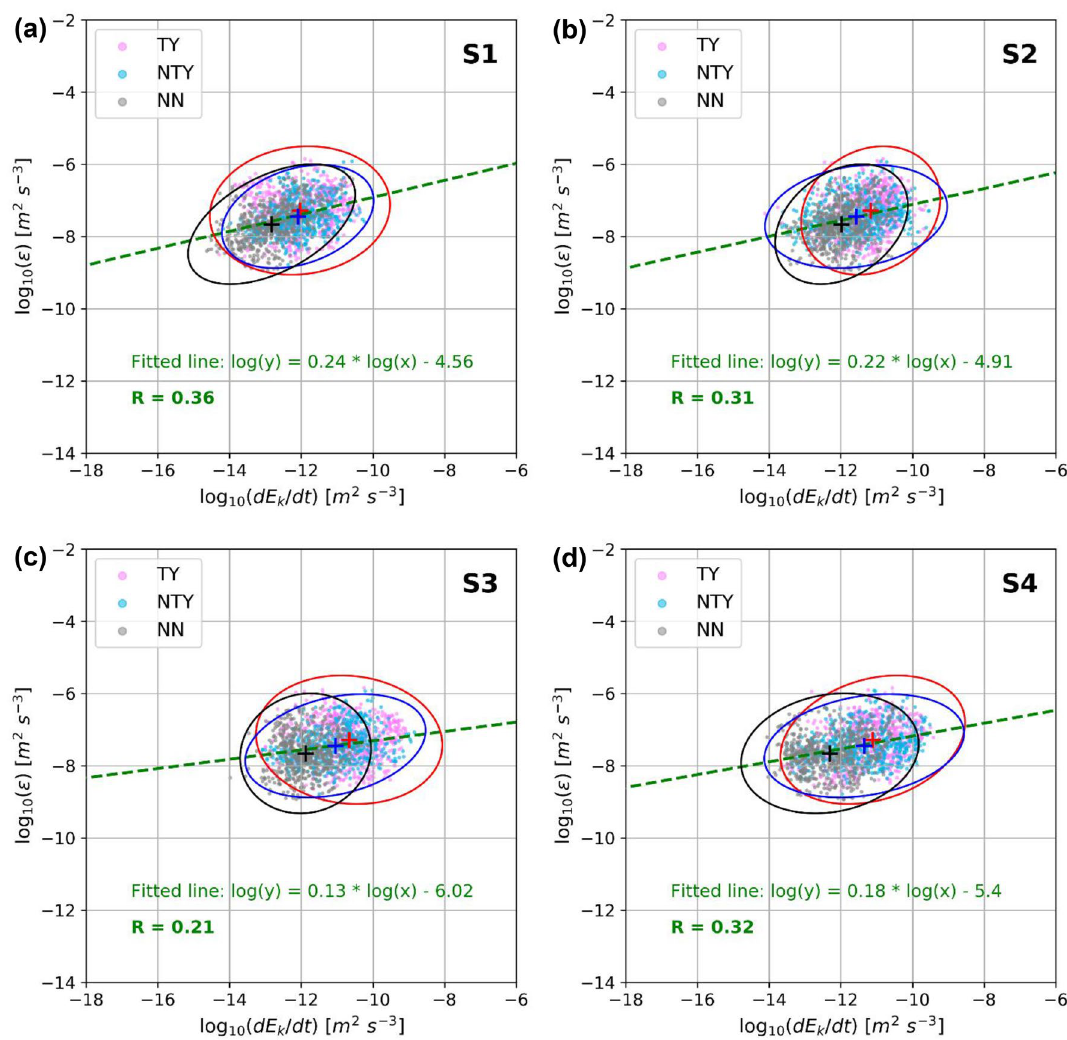
Figure 4. TDKE from the OBS ( a ) S1, ( b ) S2, ( c ) S3, and ( d ) S4 against T-string-inferred turbulent kinetic energy dissipation rate vertically averaged over 200-m during the TY (pink dots), the NTY (light blue dots), and the NN (gray dots) period. All datasets are from the three-day time series shown in Fig. 3, using a 15-min time window moving average with the half-window shift. Red, blue, and black crosses/ellipses show averaged values/ three-sigma confidence intervals of the energy distributions, respectively. The dashed green line is the log–log regression line to fit all three-period energy distributions. R is the Pearson correlation coefficient between two